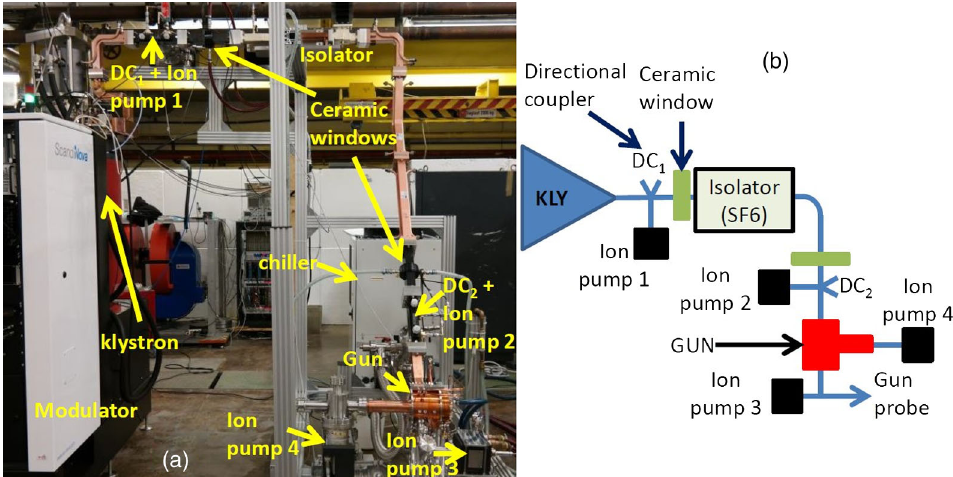
FIG. 19. (a) Picture of the high power test stand at Bonn University; (b) schematic layout of the test setup and detail of the rf gun under the high power test.